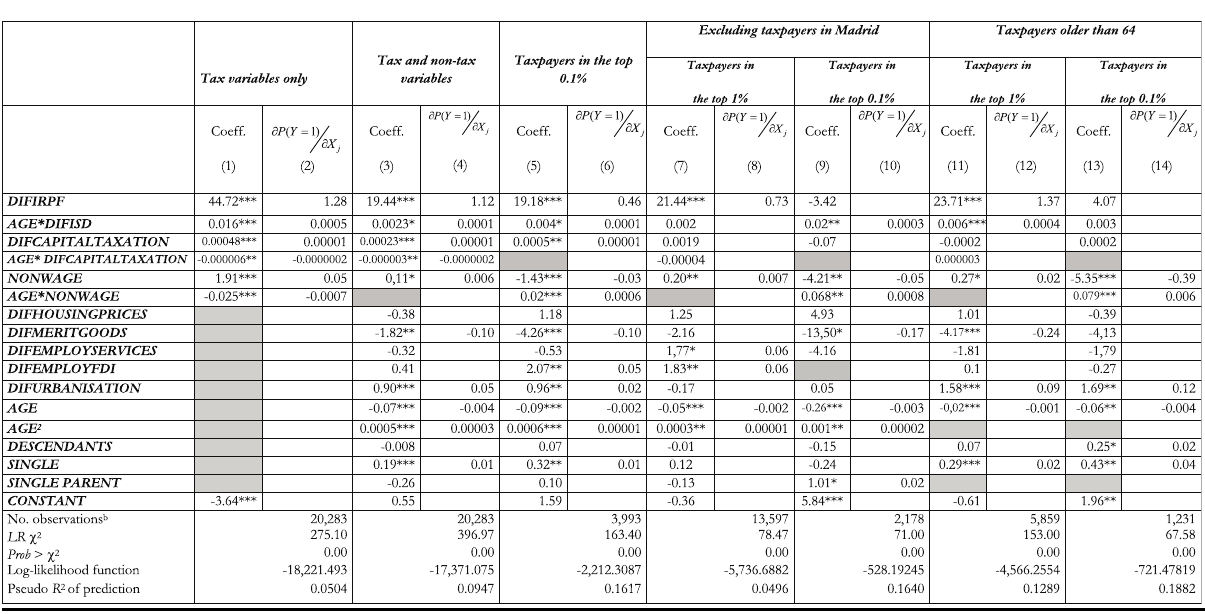
a The table shows, in successive columns, the value of the estimated coe ffi cient in each of the suggested scenarios and the marginal e ff ect of the signi fi cant variables over the probability that the di ff erent endogenous variables take the value 1. b The number of observations in the Panel corresponding to the top 1% ( or 0.1%, as applicable ) of the richest taxpayers in the total population of IRPF